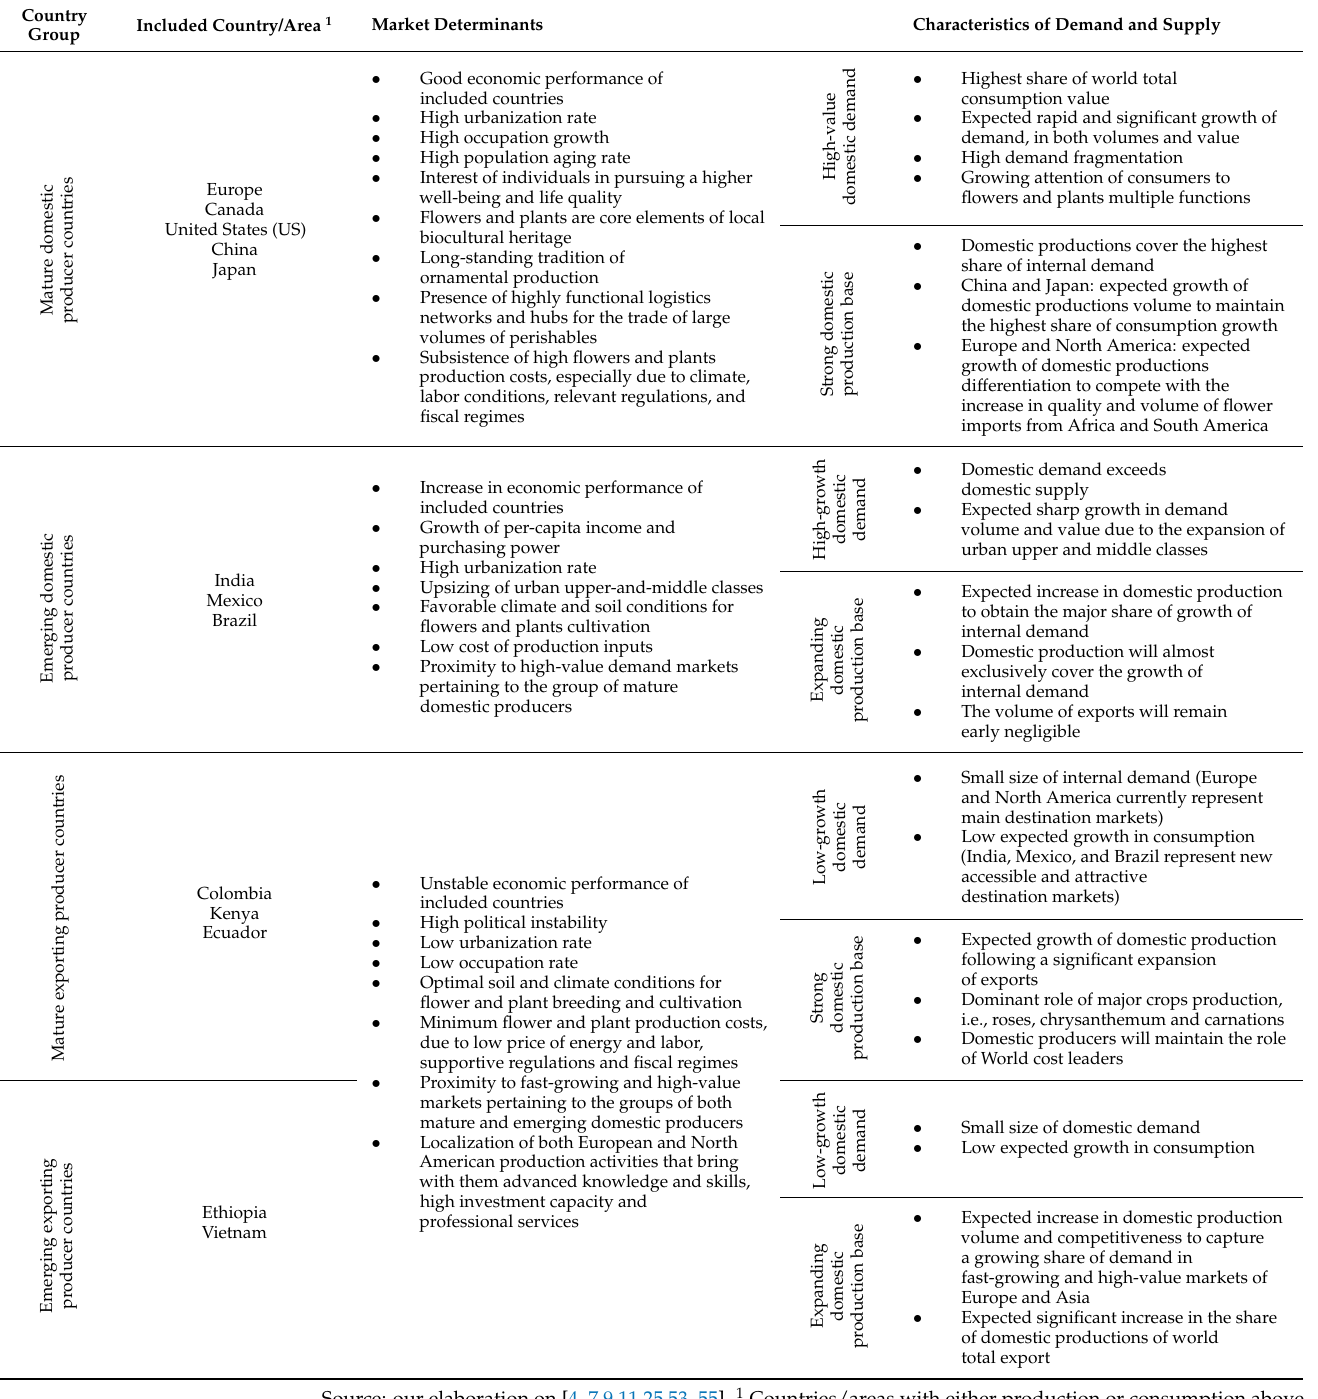
Table 4. The World ornamental market scenario: a